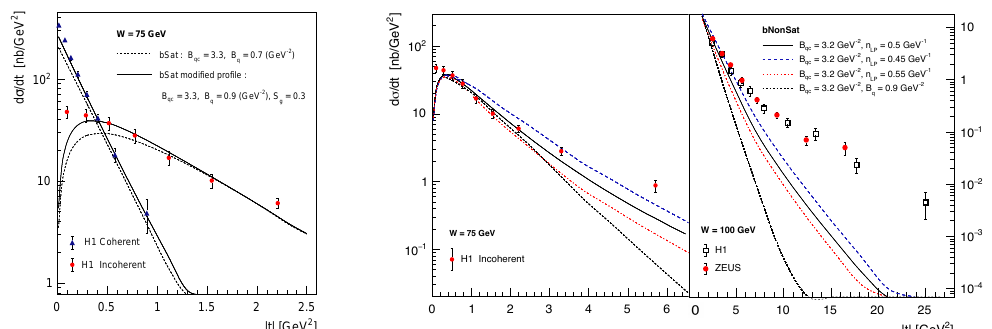
Figure 1: The | t | dependence of J / Ψ photoproduction [ 3,14,15 ] in the hotspot model with the gaussian profile & modified profile in bSat model on left panel and with gaussian & laplace profile in bNonSat model on the right